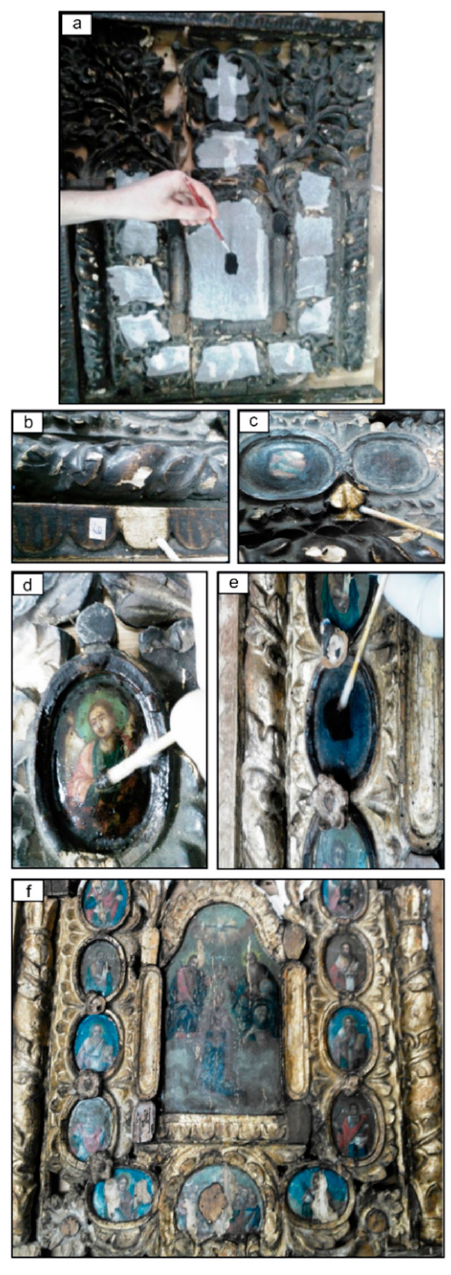
Figure 14. Preventive consolidation and cleaning of various forms of dirt: ( a ) The consolidation of the painting layer; ( b , c ) Removal of the dirt with ethanol and Contrad from the polychrome surface; ( d , e ) Details from the removal of adherent and semi-adherent dirt from the painting layer; ( f ) Removal of adherent dirt from polychrome surfaces and extended gilding (final detail).